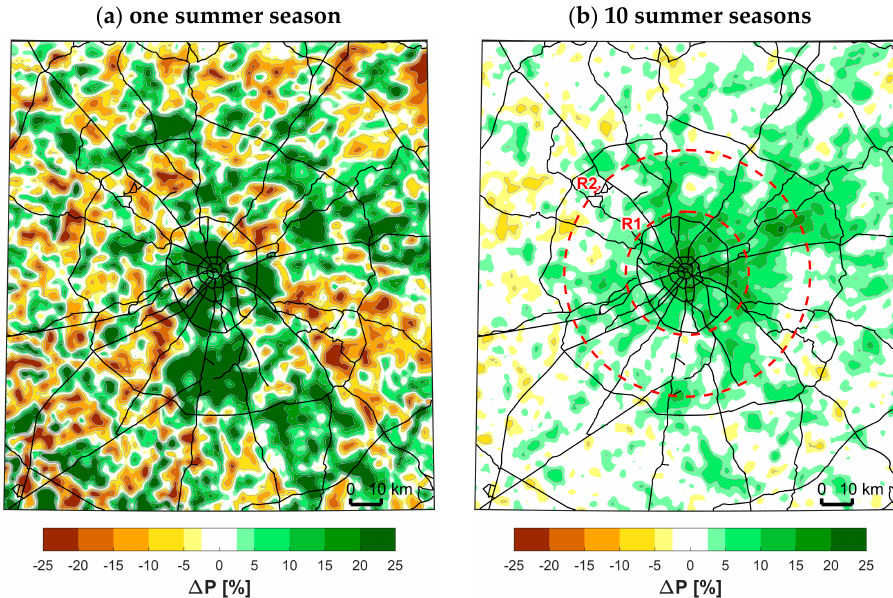
Figure 11. Modeled response of summer precipitation amount to switching on the urban canopy model ( Δ P): for 2014 year ( a ); and averaged over 10 summer seasons (2007–2016) ( b ). Percentage values are calculated in relation to the modeled precipitation amount for “noURB” experiments. Red circles in ( b ) represent the R1 and R2 areas used in analysis.